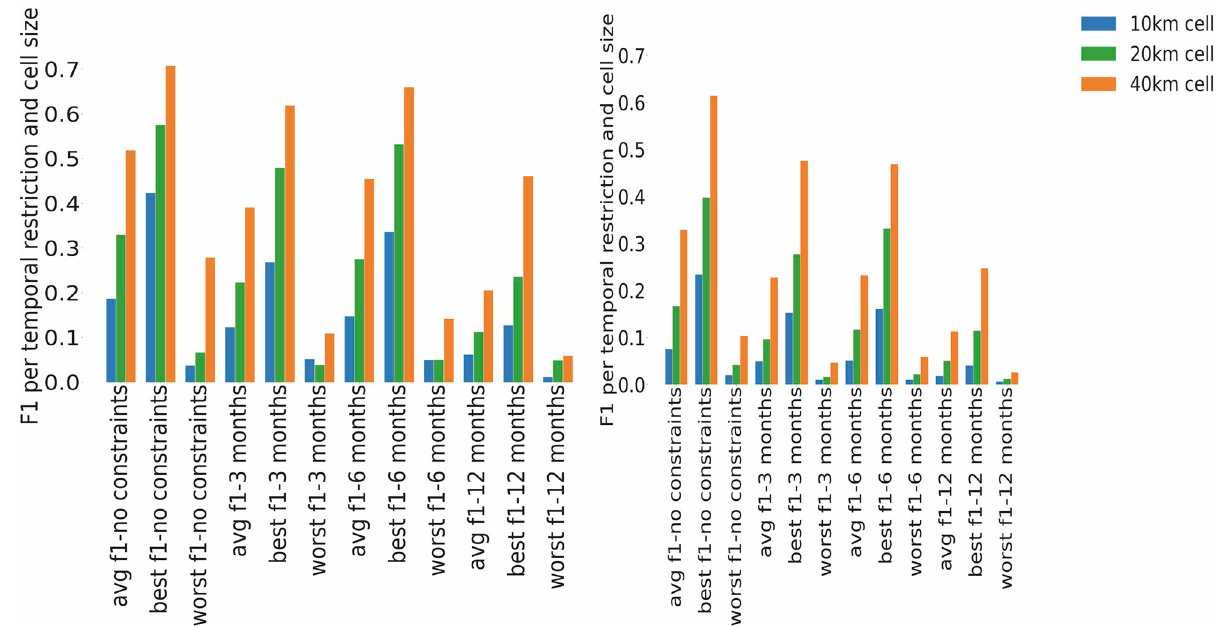
Fig 8. Comparison of average, best, worst F1 measure values per temporal restriction and cell size for invasive species: The one by one analysis is on the left, the three by three analysis on the right.